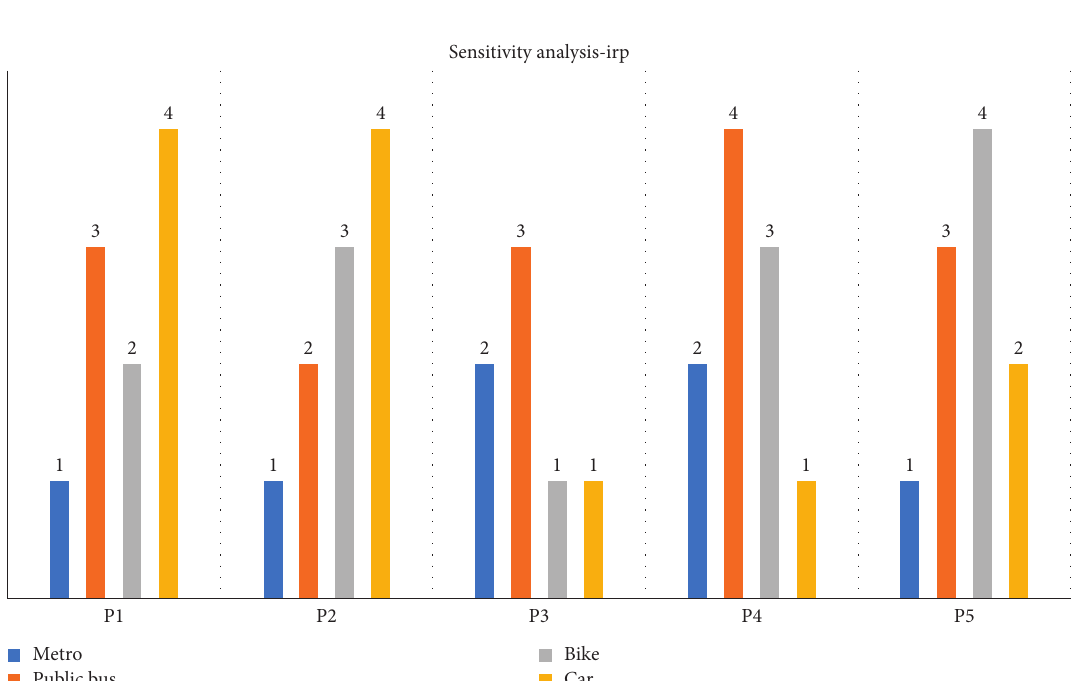
Figure 9: Sensitivity analysis using